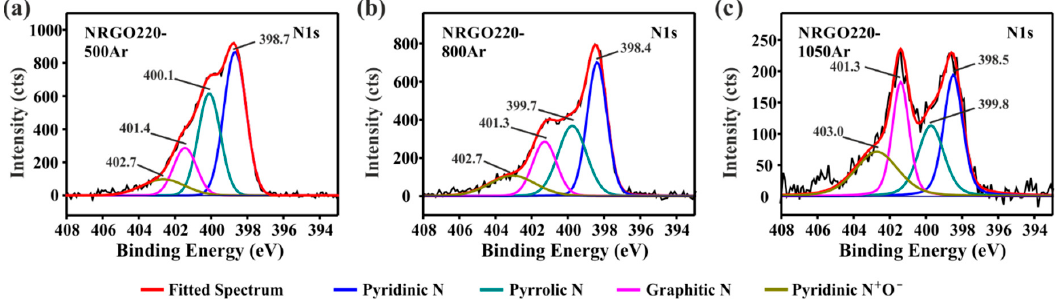
Figure 7. High-resolution N1s spectra of ( a ) NRGO220-500Ar, ( b ) NRGO220-800Ar, and ( c )